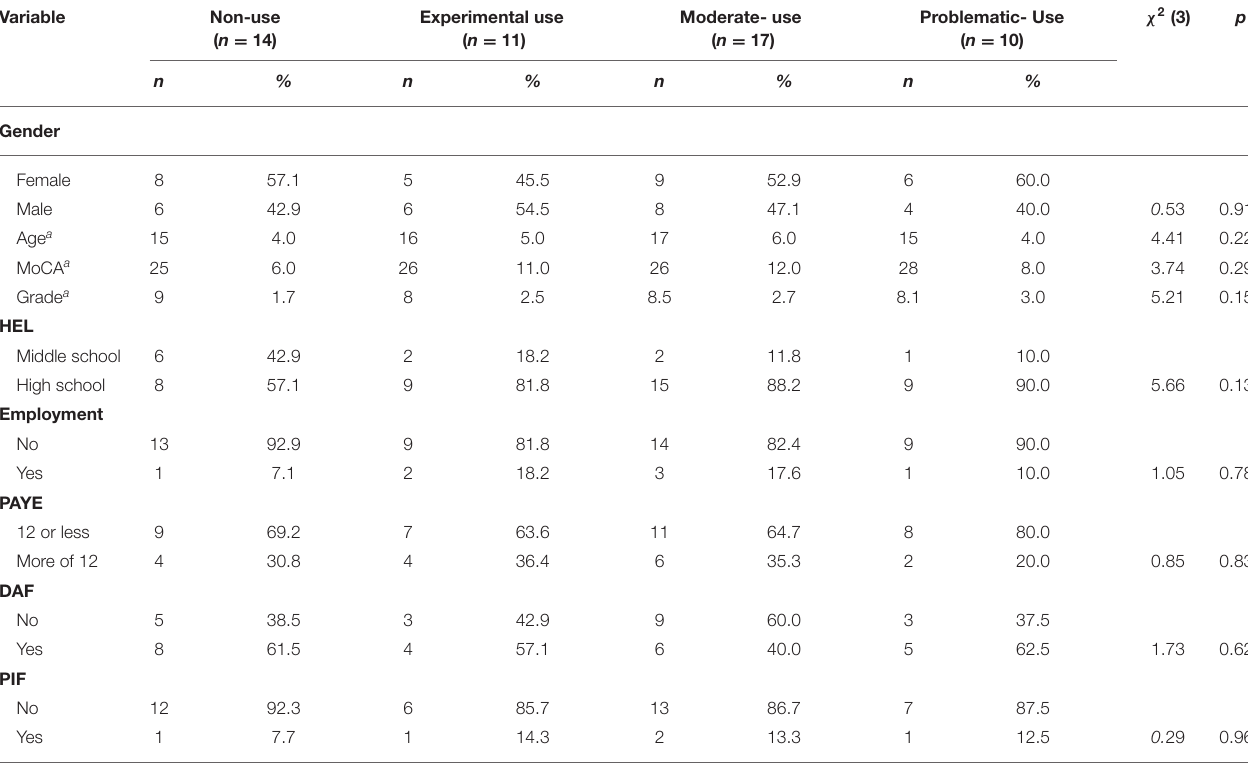
TABLE 1 | Sociodemographic characteristics per type of drug involvement.